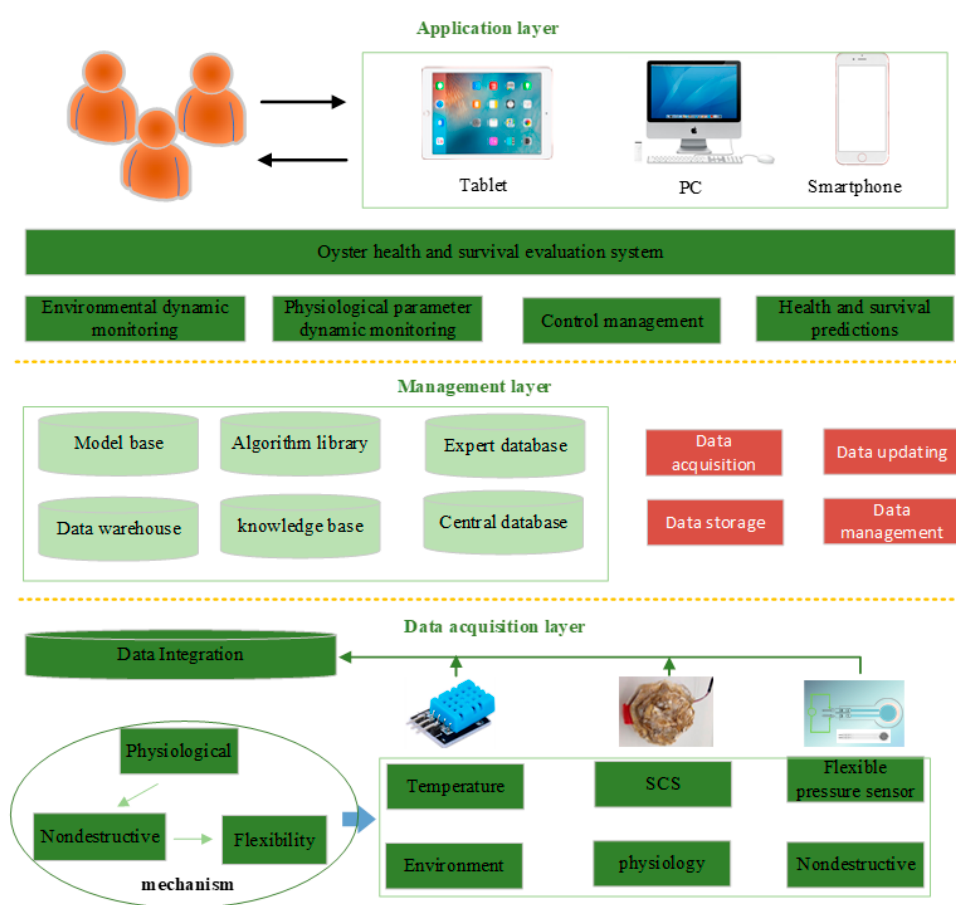
Figure 1. Overall framework of the intelligent system for oyster health evaluation.